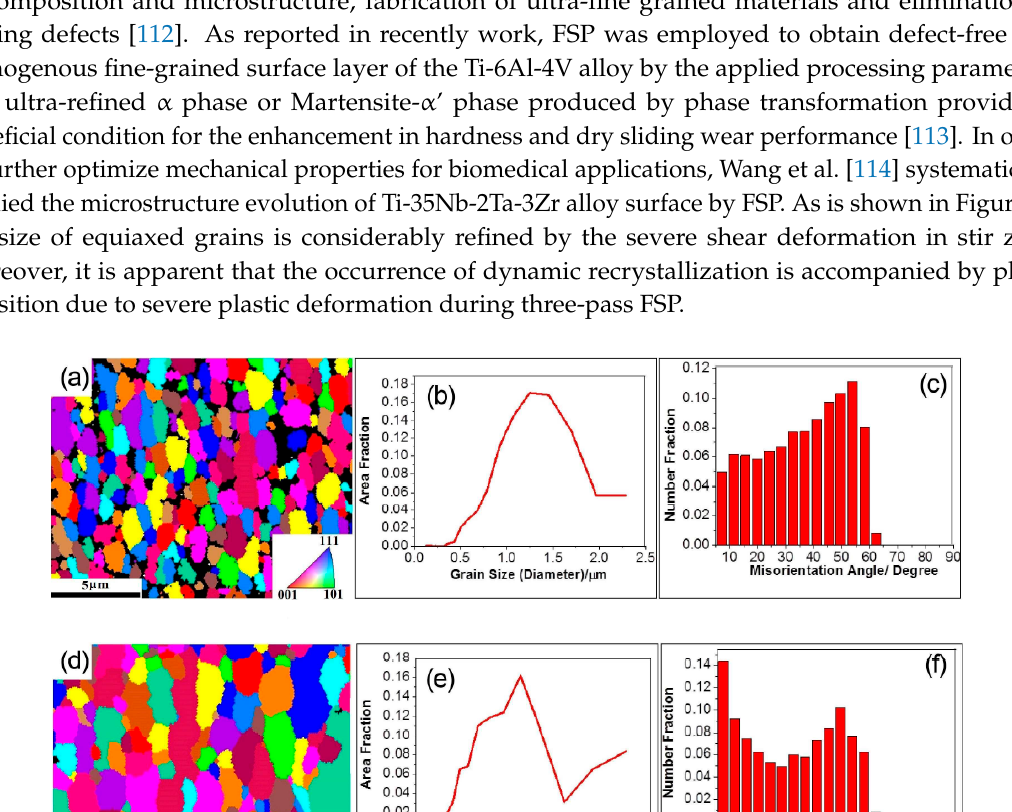
Figure 19. Schematic illustration of the process of producing the FSP-modified Ti/SiC metal matrix nano-composite (MMNC) [117].